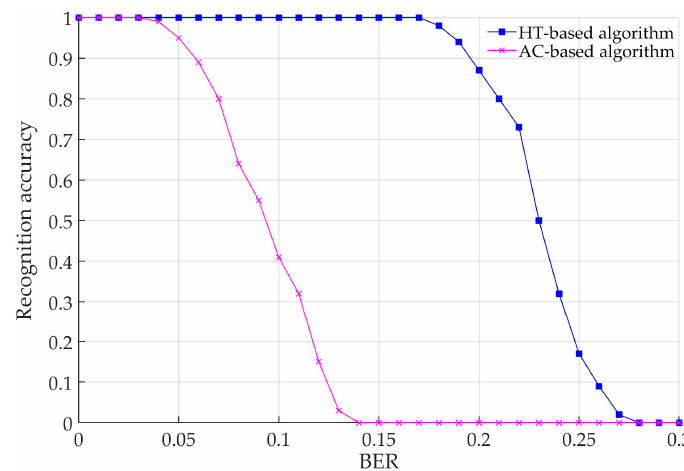
Figure 9. Comparison between HT-based recognition algorithm and AC-based algorithm. HT, Hough Transform; AC, autocorrelation.